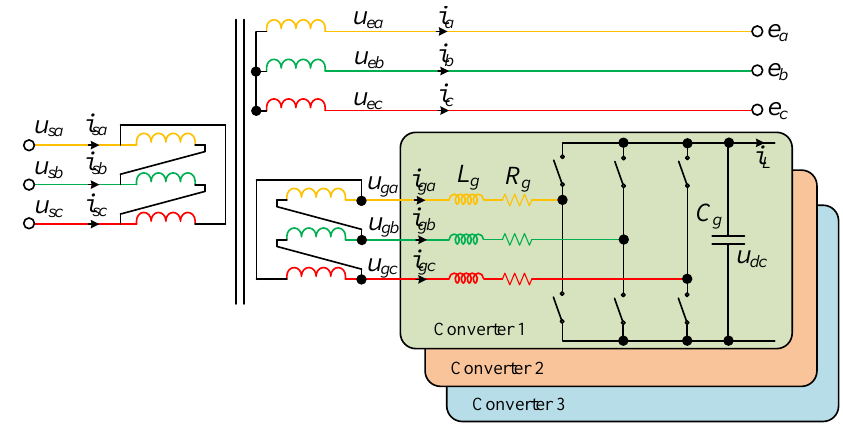
Figure 7. Equivalent diagram of shunt